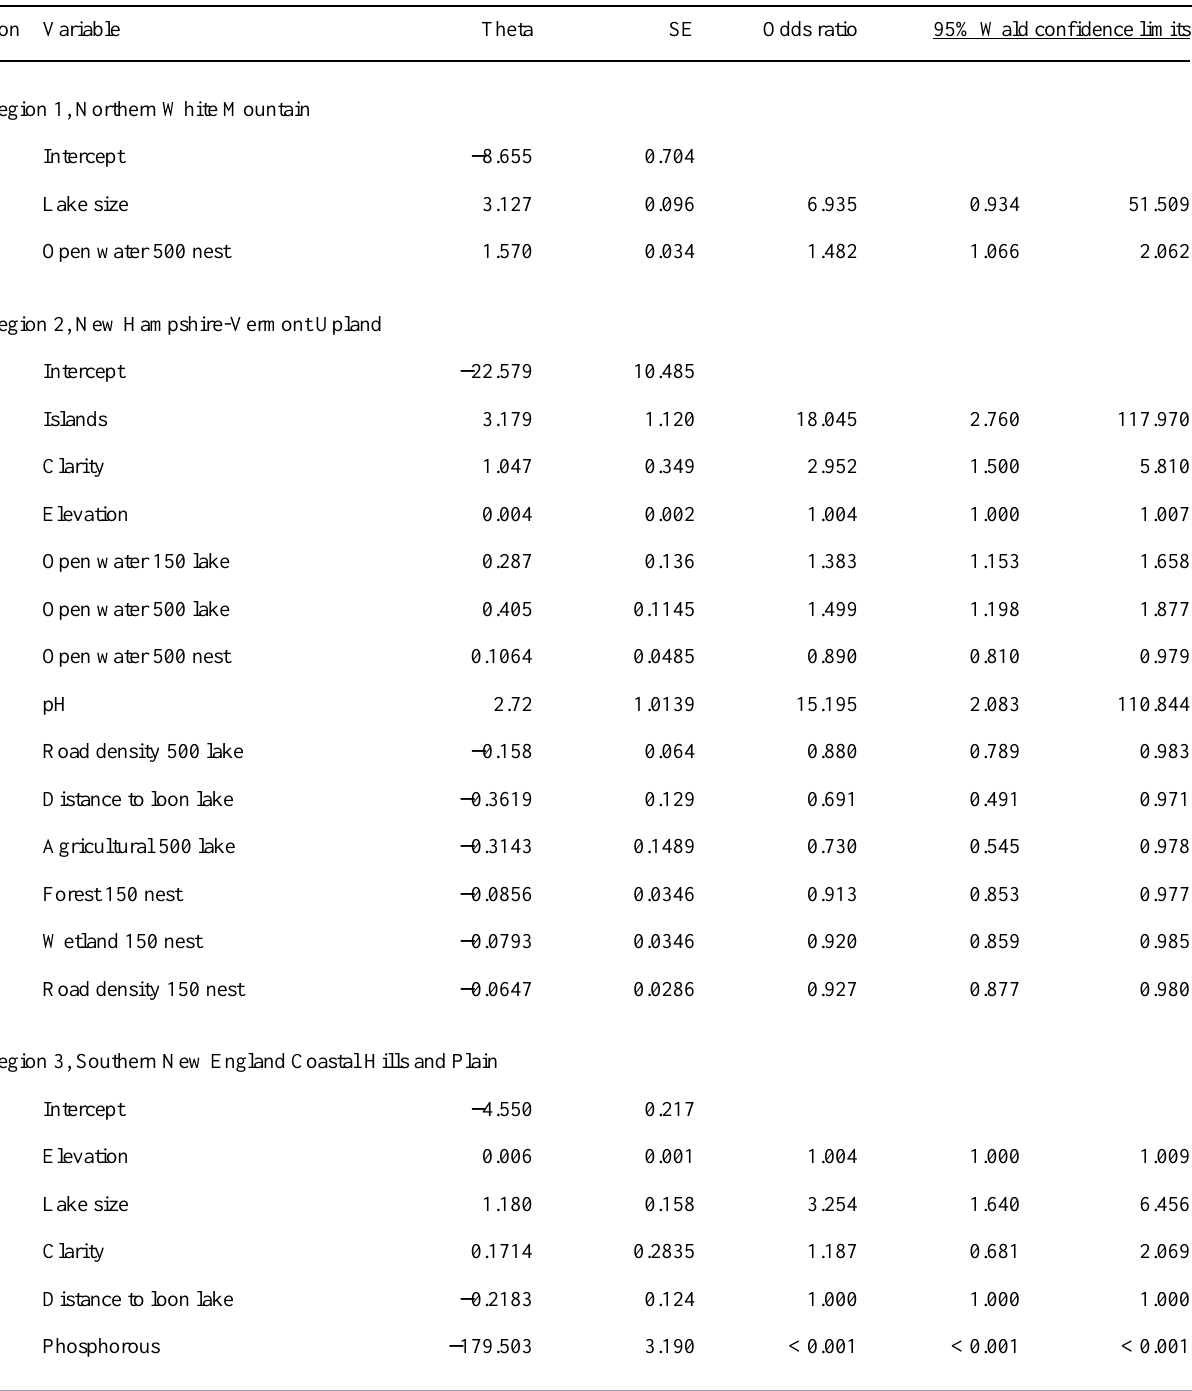
Table 8. Model averaged parameter estimates and odds ratio estimates with confidence intervals for ecoregional composite models and the statewide model. These parameters constitute the final averaged models for each ecoregion and may be used directly to predict Common Loon nest presence regionally and throughout the state of New